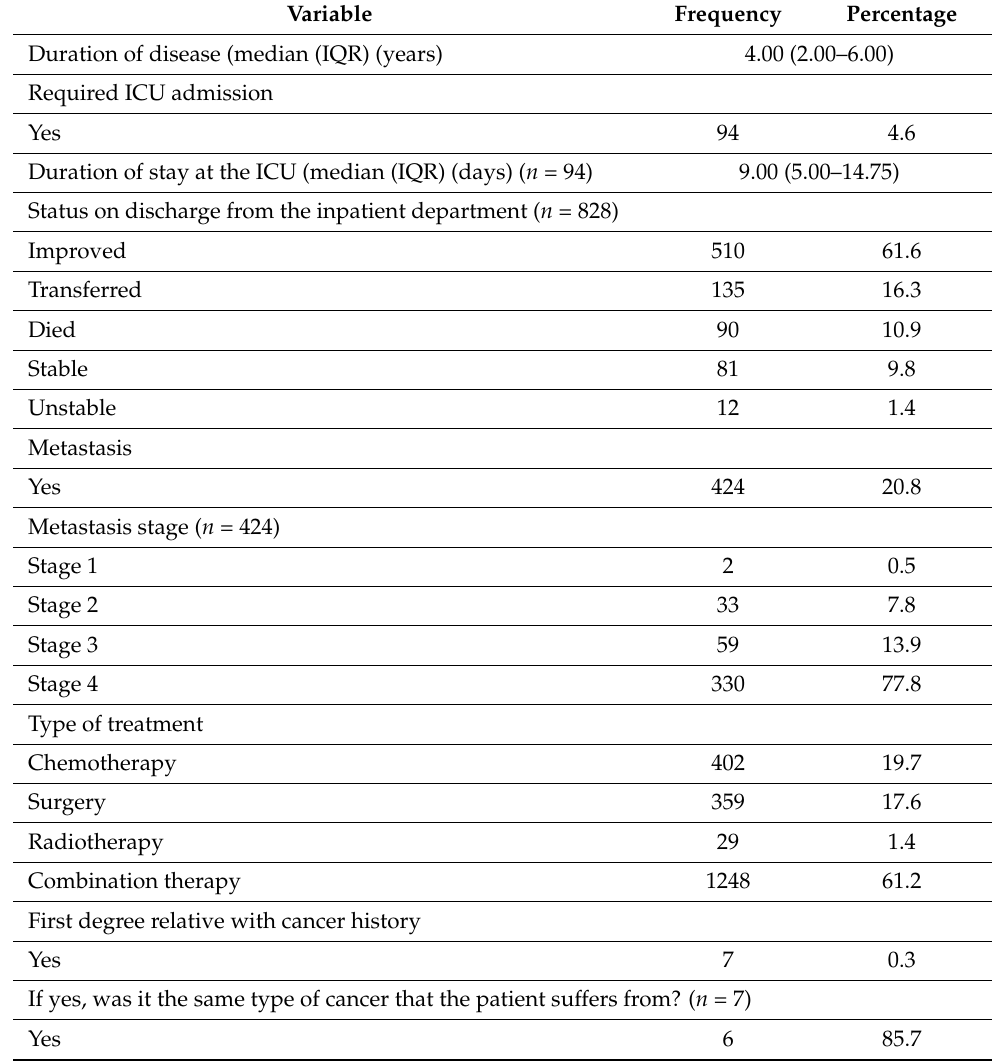
Table 2. Characteristics of disease among the study